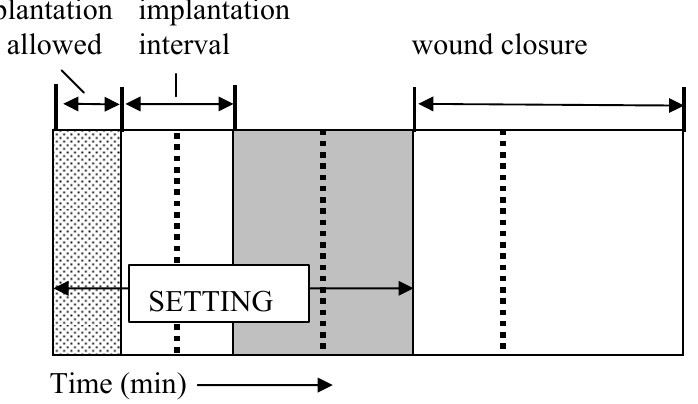
Figure 2. A diagram of the setting parameters relevant for a calcium orthophosphate cement: CT – cohesion time; I – initial setting time; F – final setting time. Adapted from Ref. [25] with